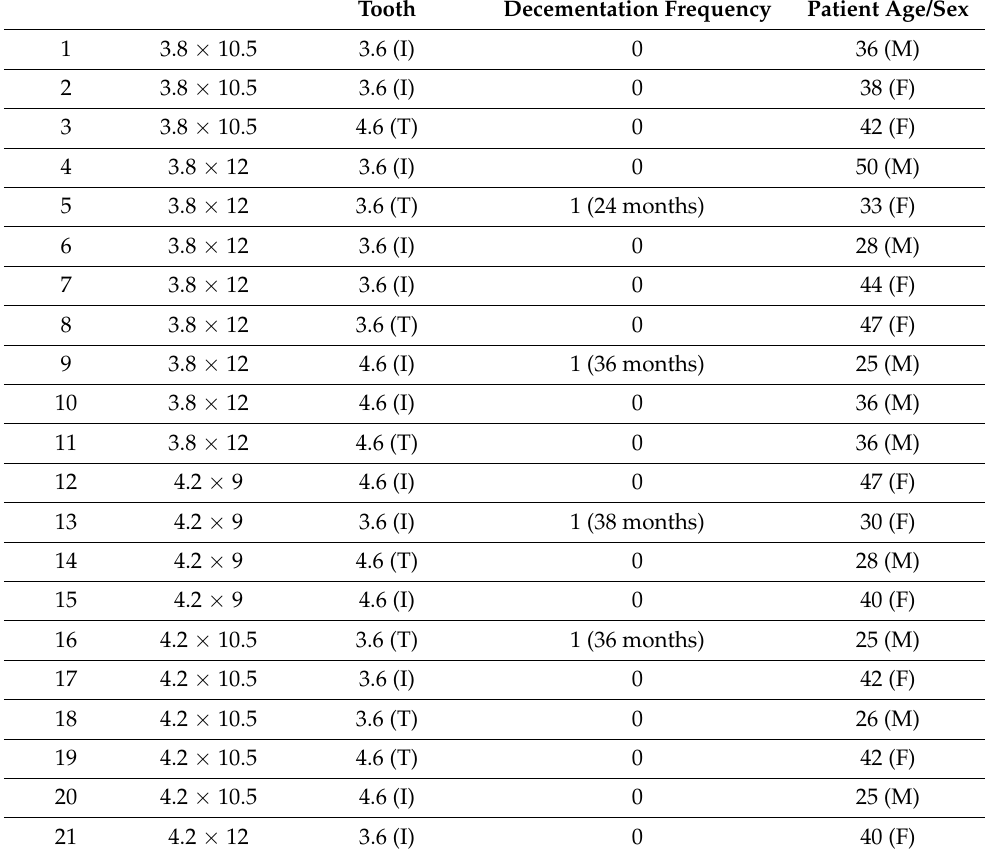
Table 1. Characteristics and complications of the 36 cement-retained implant-supported single crowns with the two different cements. (I) Implacem; (T) Temp Bond; (X months) Months to the